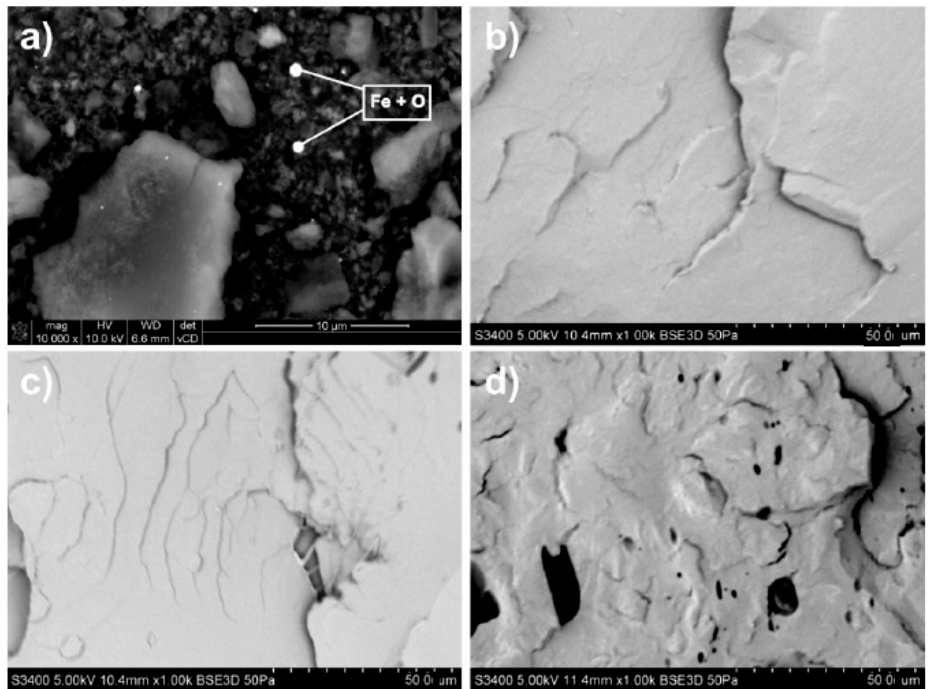
Figure 2. SEM images of: ( a ) GD nanoparticles of 6 wt.% ash content; magnification 10,000×, and fractured surface of: ( b ) uuPLA, ( c ) upPLA, and ( d ) PLA-FG; magnification 1000×. uuPLA—unfilled and unprocessed PLA; upPLA—unfilled and processed PLA; PLA-FG—PLA with plasticizer and compatibilizer.